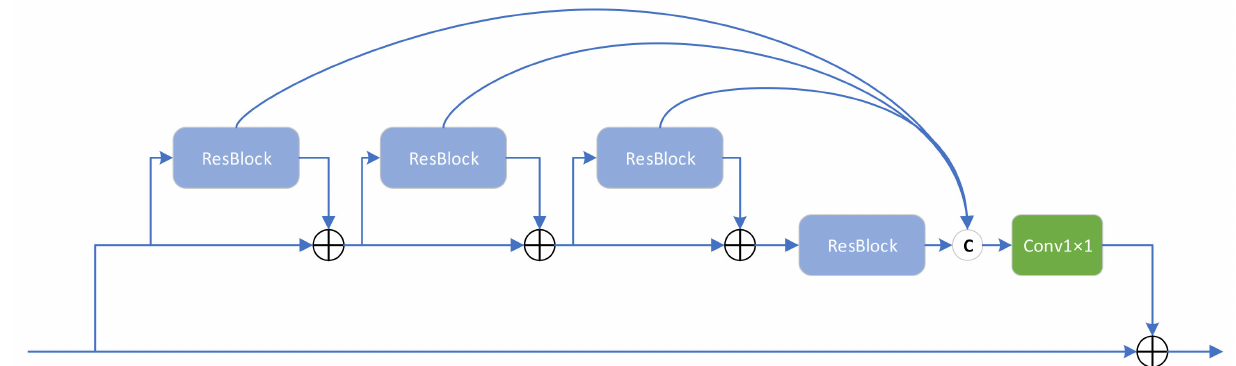
Figure 5. Detailed structure diagram of the residual feature aggregation framework (RFANet).